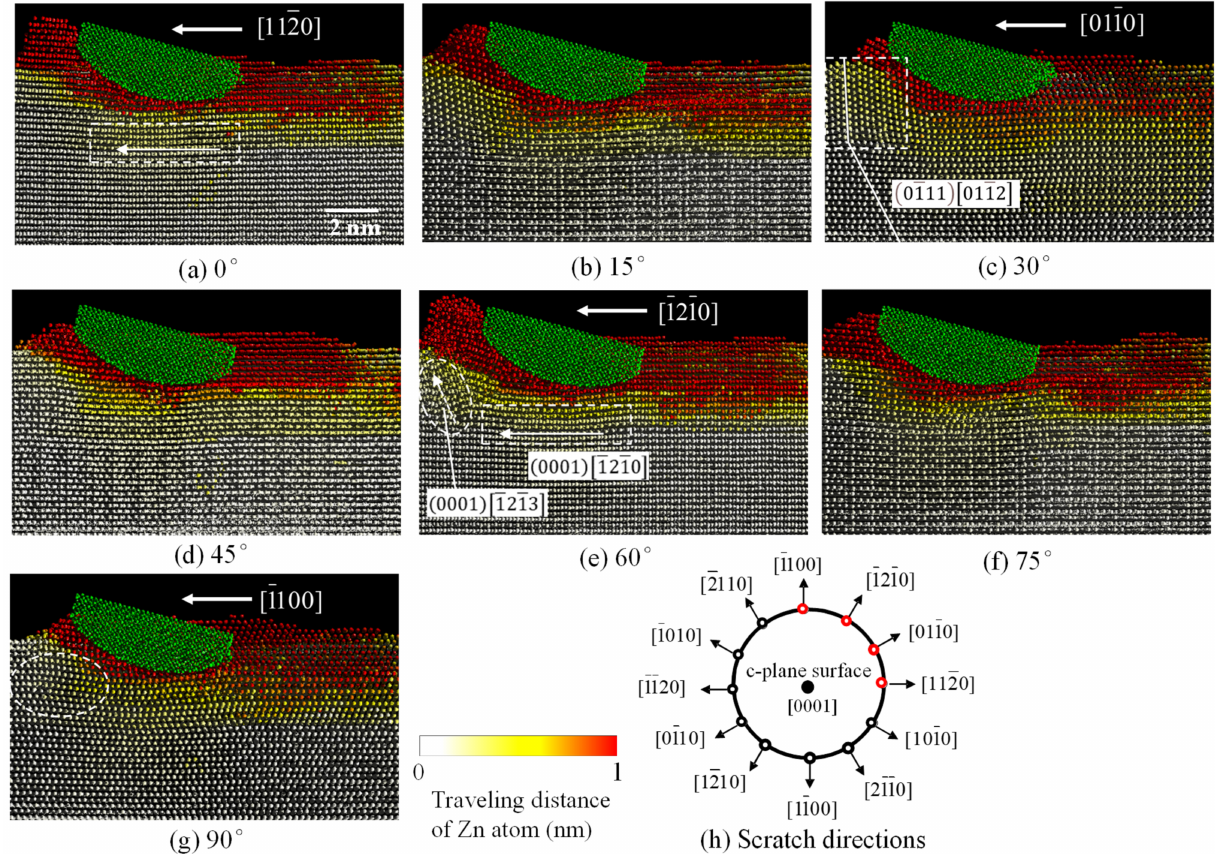
Figure 9. Snapshots of the cross-section for various scratch directions such as ( a ) 0, ( b ) 15, ( c ) 30, ( d ) 45, ( e ) 60, ( f ) 75 and ( g ) (cid:2) (cid:3) 90 degrees from 1120 , where the color bar shows the traveling distance of Zn atom from initial position, and ( h ) is the schematic for scratch directions